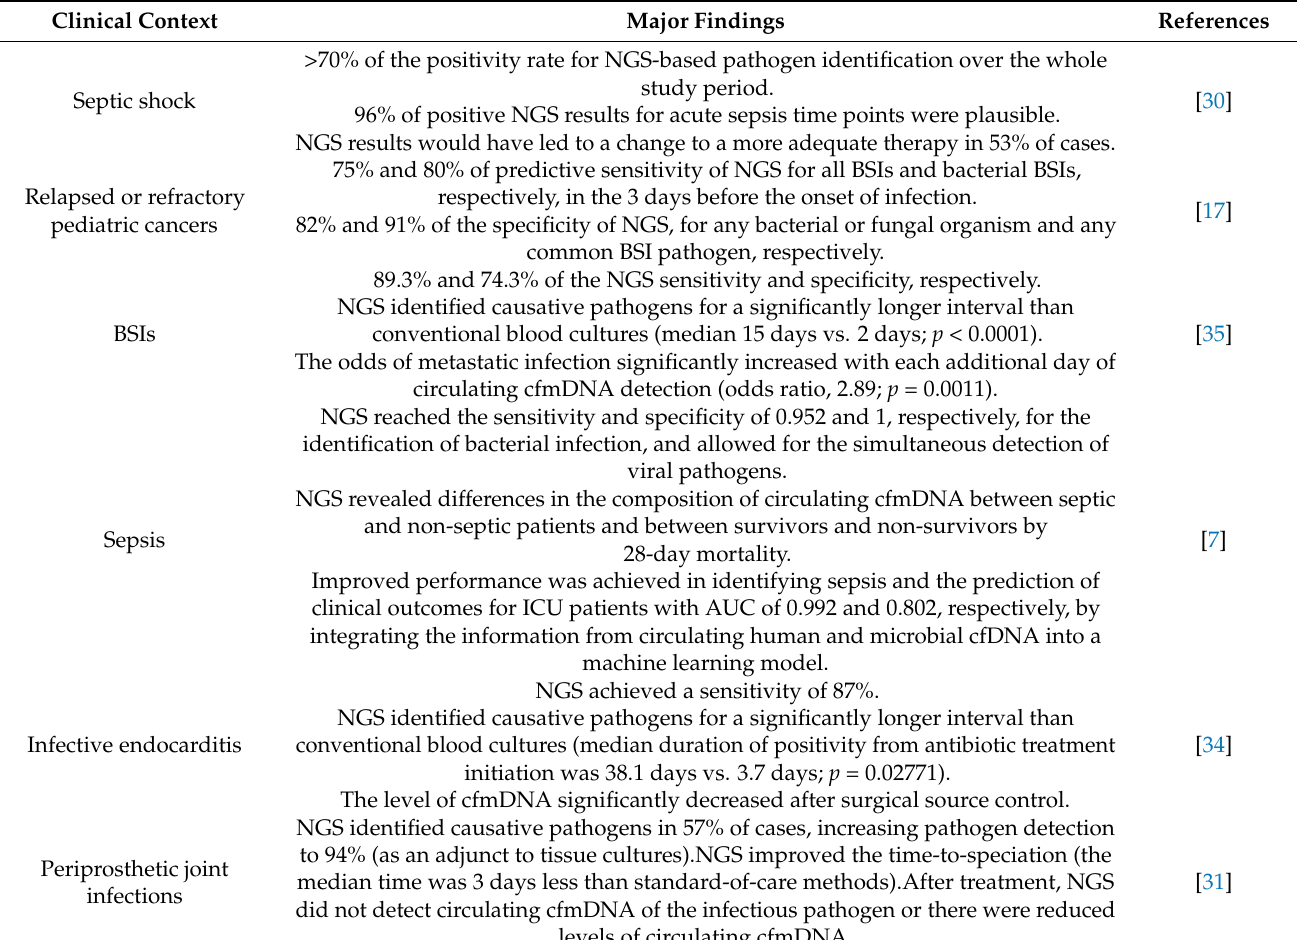
Table 1. Potential application of plasma cfmDNA sequencing in clinical